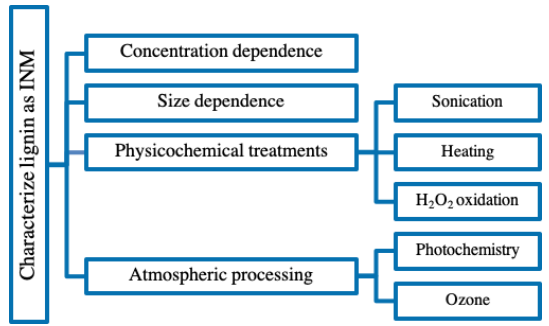
Figure 2. Overview of conducted experiments to characterize lignin as an IN macromolecule